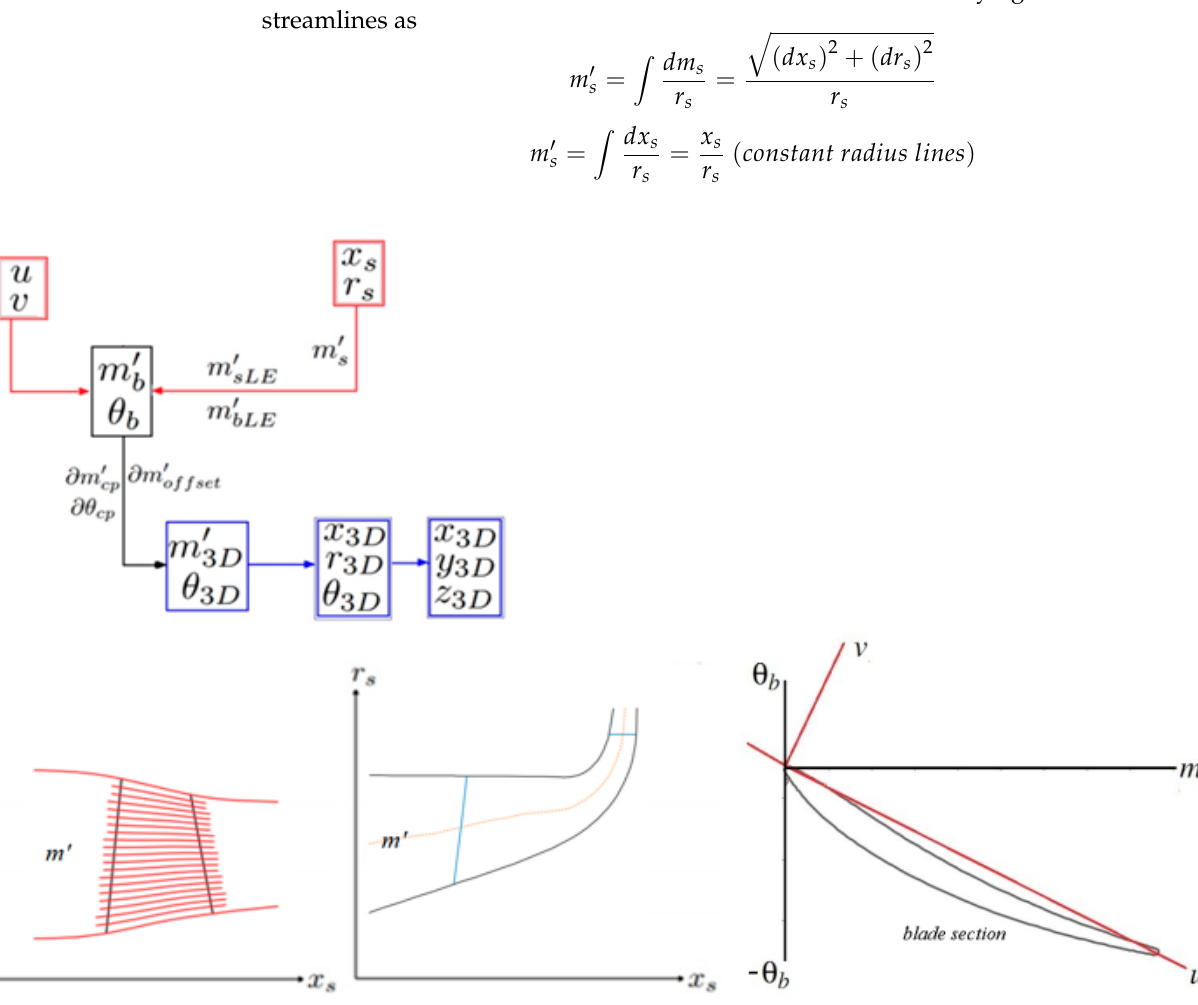
Figure 2. Coordinate systems used for 3D blade generation with meridional view for both configura- tions and relation between ( u , v ) and ( m (cid:48) , θ b ) axes (right). b Camber-line or meanline is created in the unit chord ( u , v ) space. Thickness